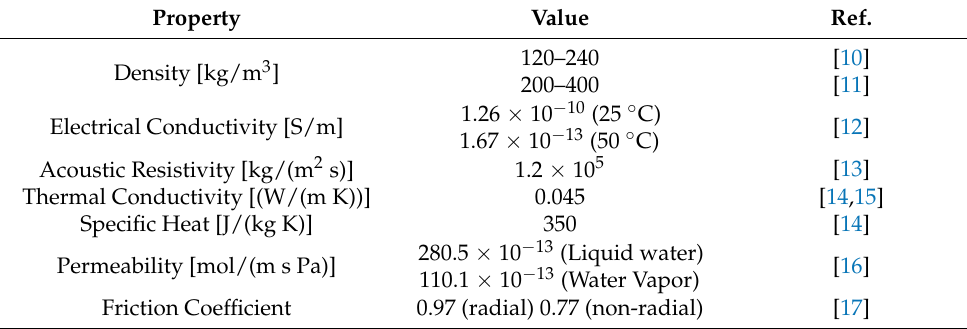
Table 1. General properties of